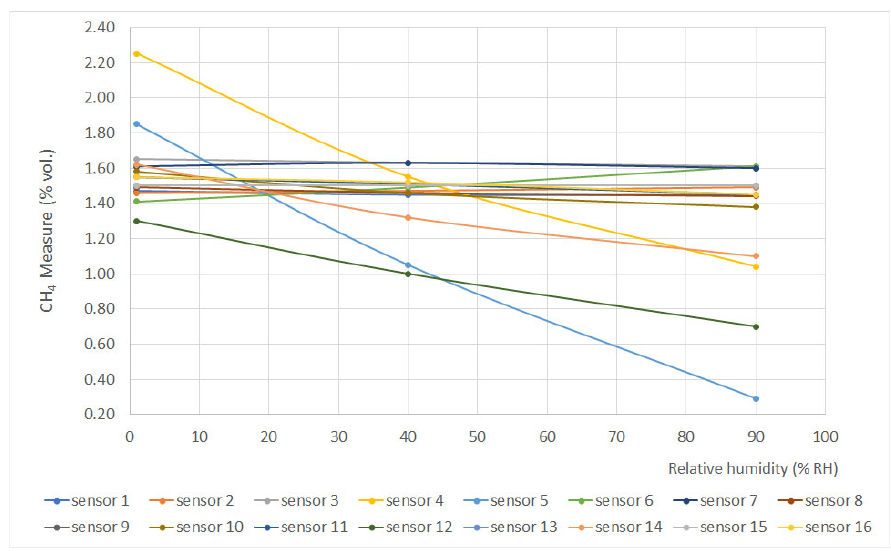
Figure 9. Humidity curves for 1.5% vol.